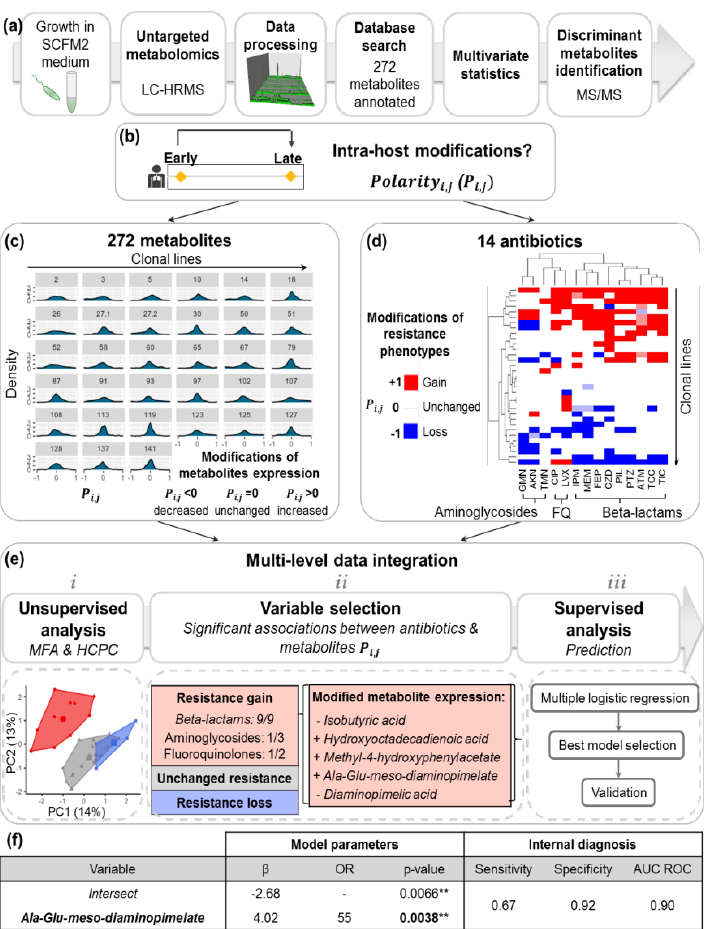
(Figure 2e). Clusters 2 and 3 were associated with an unchanged or decreased antibiotic resistance, respectively (in white and blue, Figure 2e).